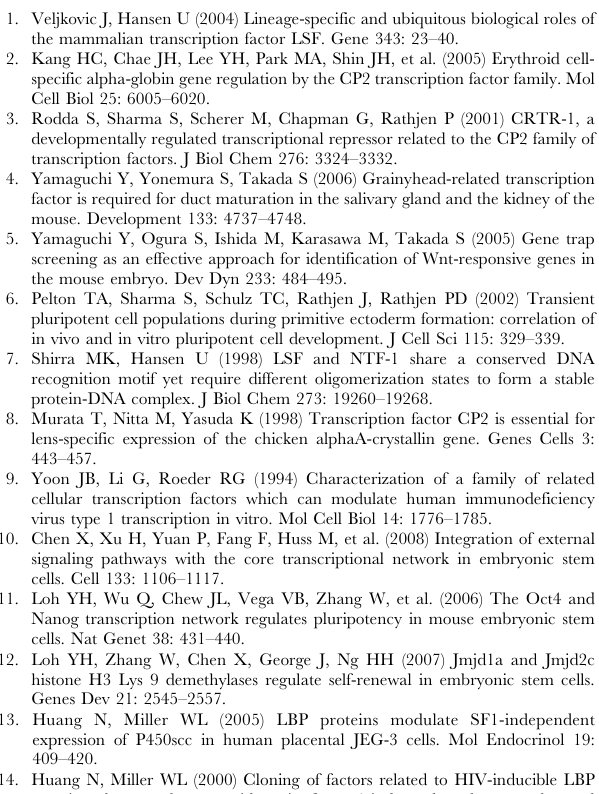
from experiments included in Fig. 5B. Cells were transfected with the appropriate expression plasmids, as indicated (ng). Proteins